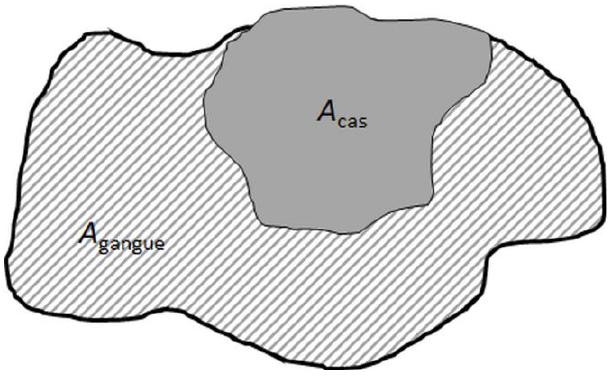
Figure 7. Typical 2D projection of a particle in the cutting plane from MLA measurement.